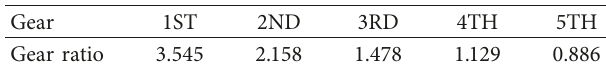
Table 2: Corresponding relationship of rotational speed and ve- hicle